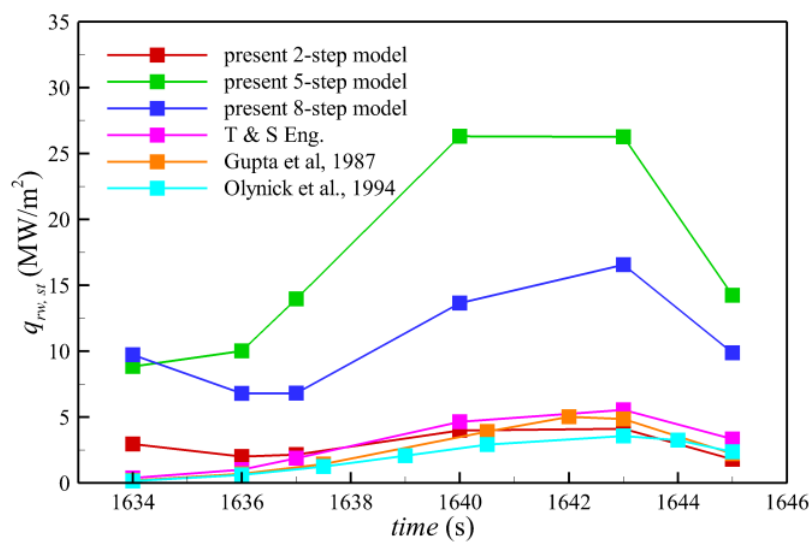
Figure 7. Radiative heating at the stagnation point of Fire II throughout the trajectory predicted by the present algorithm with 2-step model, 5-step model, 8-step model, T & S engineering relation, Gupta et al., and Olynick et al.